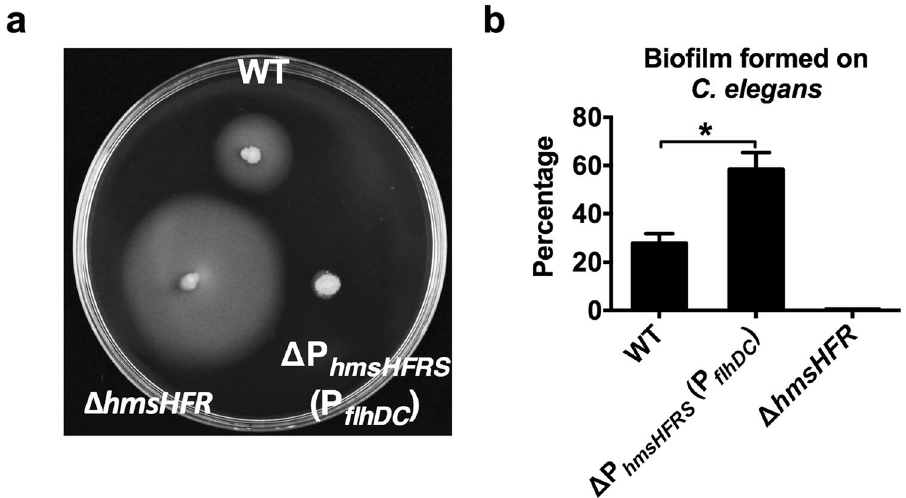
Figure 6. RovM modulates biofilm/motility transition through reversely regulating the expression of flhDC and hmsHFRS . ( a ) Mobility of WT, Δ hmsHFR and the promoter replacement strain Δ P hmsHFRS ( P flhDC ) on semi- solid agar plates. ( b ) Biofilm formed on C. elegans by WT, Δ P hmsHFRS ( P flhDC ) and Δ hmsHFR . Data shown are the average of three independent experiments; error bars indicate SD from three independent experiments. * P < 0.05; ** P < 0.01; *** P <